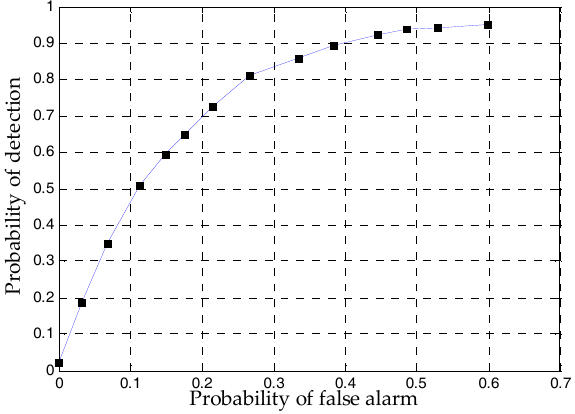
Figure 8. The ROC curve of the proposed detector.